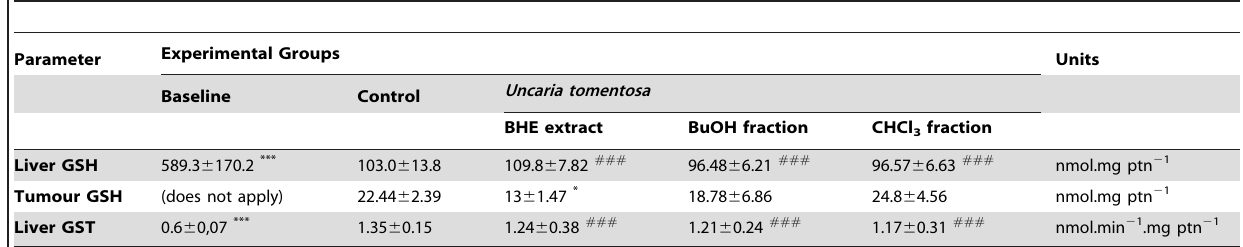
Table 2. GSH levels in liver and tumour tissue, as well as GST activity in the liver of W256 tumour-bearing rats treated with U. tomentosa BHE extract or its two fractions (BuOH and CHCl 3 ).